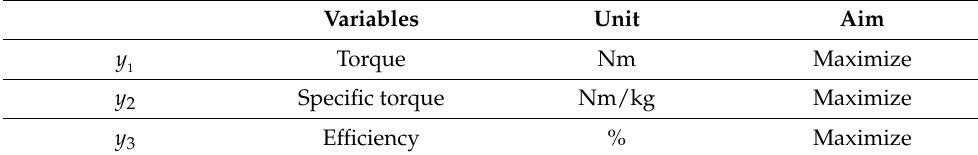
Table 3. The objective of the